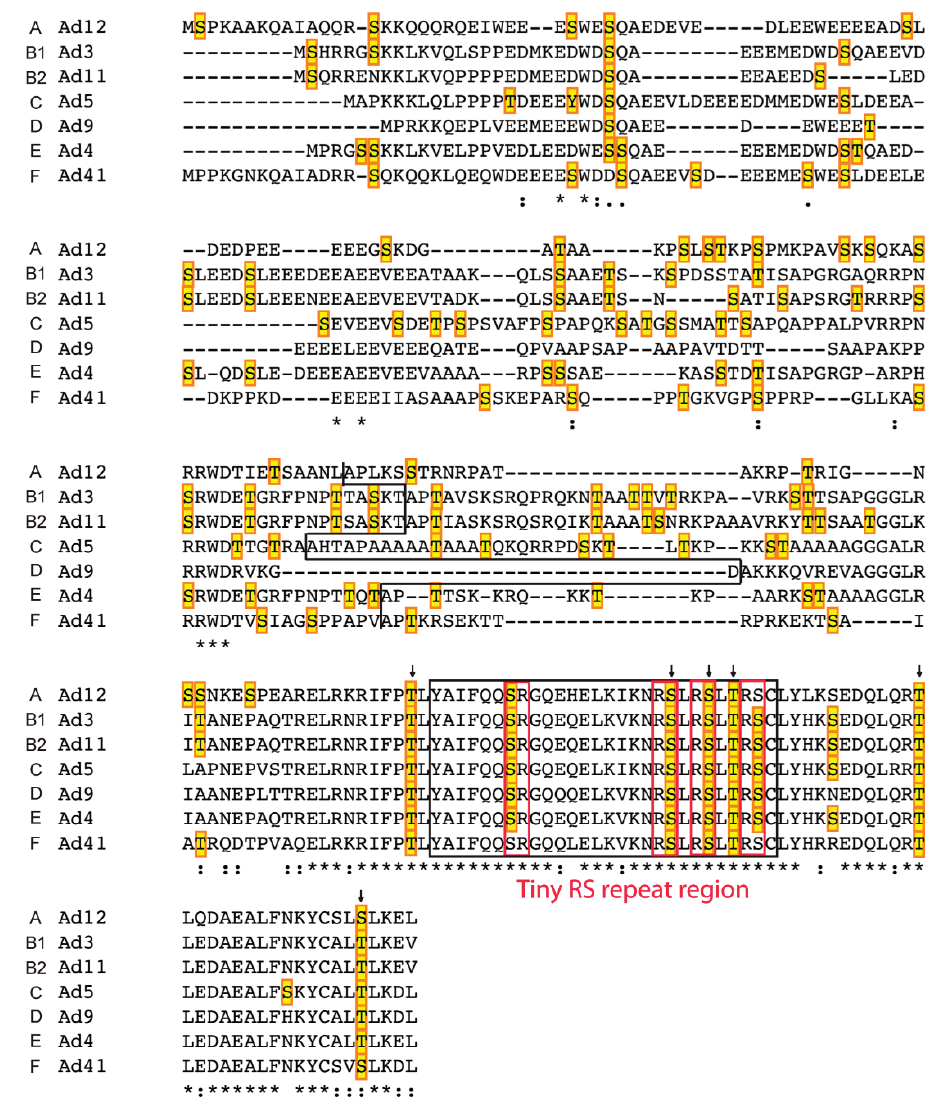
Figure 5. Alignment of L4-33K proteins from different human serotypes and their putative phosphorylation sites. The amino acid sequence of the indicated L4-33K proteins was aligned using Clustal Omega software. The conserved residues are indicated by star ( * ), colon (:), and period (.) according to the level of identity and similarity of the amino acid aligned: full identity, amino acids with similar characteristics, and weakly similar residues, respectively. The black line separates the N -terminus (shared with the respective L4-22K) and the C -terminal region of each serotype. The putative phosphorylation sites detected with NetPhosK 1.0 are marked in yellow boxes, and the conserved residues predicted to be phosphorylated by the same kinase are indicated by arrows (see also Table S1B). The ds domain is shown with a black-box with the tiny SR repeats indicated in red